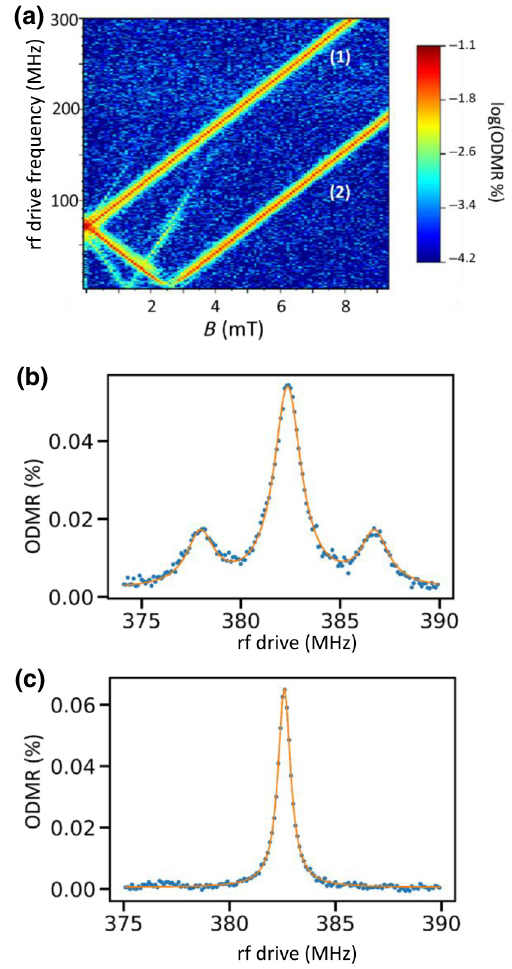
FIG. 2. V2 optically detected magnetic resonance. (a) Ground- state ODMR map as a function of external magnetic field and rf drive frequency. Transitions (1) and (2) correspond to those labeled in Fig. 1(a). The overall PL signal of the lock-in amplifier is 1.2 V, with a maximum ODMR signal of 0.08% represented on the color scale. This scan was performed with relatively low rf power. (b) Single ODMR scan on a natural isotope abun- dance sample at B = 11 mT. The presence of hyperfine-coupling- detuned side peaks is due to next-nearest-neighbor 29 Si isotopes (dose = 3 × 10 18 cm − 2 ). The rf power is − 5 dBm going to a shorted coax loop antenna (leading to approximately 200 kHz Rabi frequency). Three Lorentzian fits are shown, all with an equivalent FWHM of 1.6 MHz. (c) ODMR scan on an isopure SiC sample with the same irradiation parameters as (b) as well as equivalent rf drive power. A single Lorentzian fit is plotted, showing a FWHM of 0.71